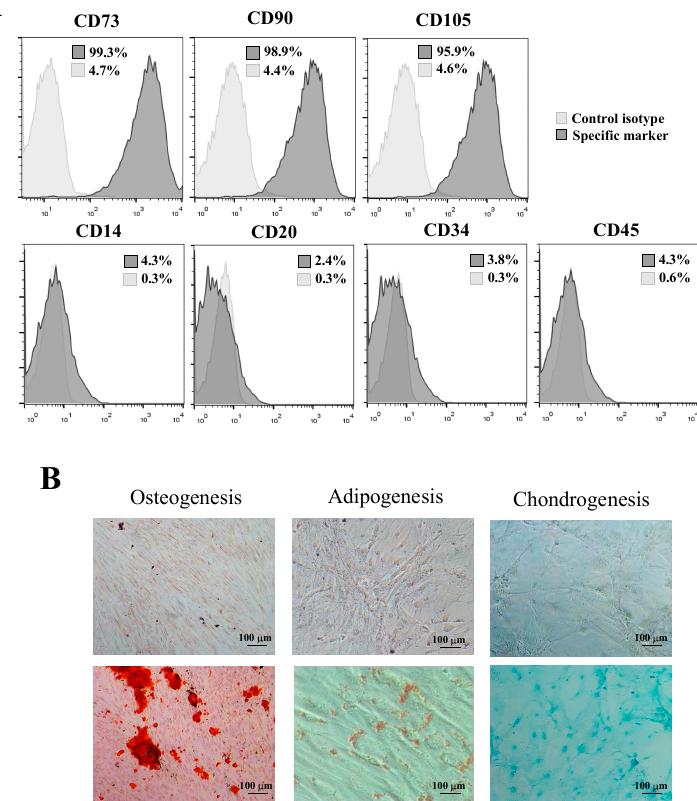
Figure 1. ( A ) Expression of mesenchymal stem cells markers CD73(99.3%), CD90(98.9%), and CD105(95.9%), and hematopoietic markers CD14(4.3%), CD20(2.4%), CD34(3.8%), and CD45(4.3%). Insert numbers inside histograms represent percentages of positive cells for each marker. Control isotypes staining are also shown. ( B ) Osteogenic, adipogenic, and chondrogenic differentiation of hPDLSCs (Alizarin red, Oil red O, and Alcian blue staining, respectively). Negative controls are also shown (top images). Scale bar: 100 μ m.